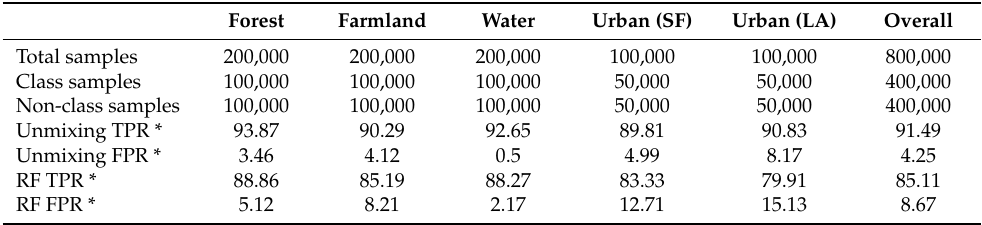
Figure 10. Map showing 100 validation points chosen over California for forest (dark green circles), farmland (light green circles), water bodies (blue boxes) and urban built-up classes (red boxes), each representing multiple (~10) points. Table 1. Confusion matrix.